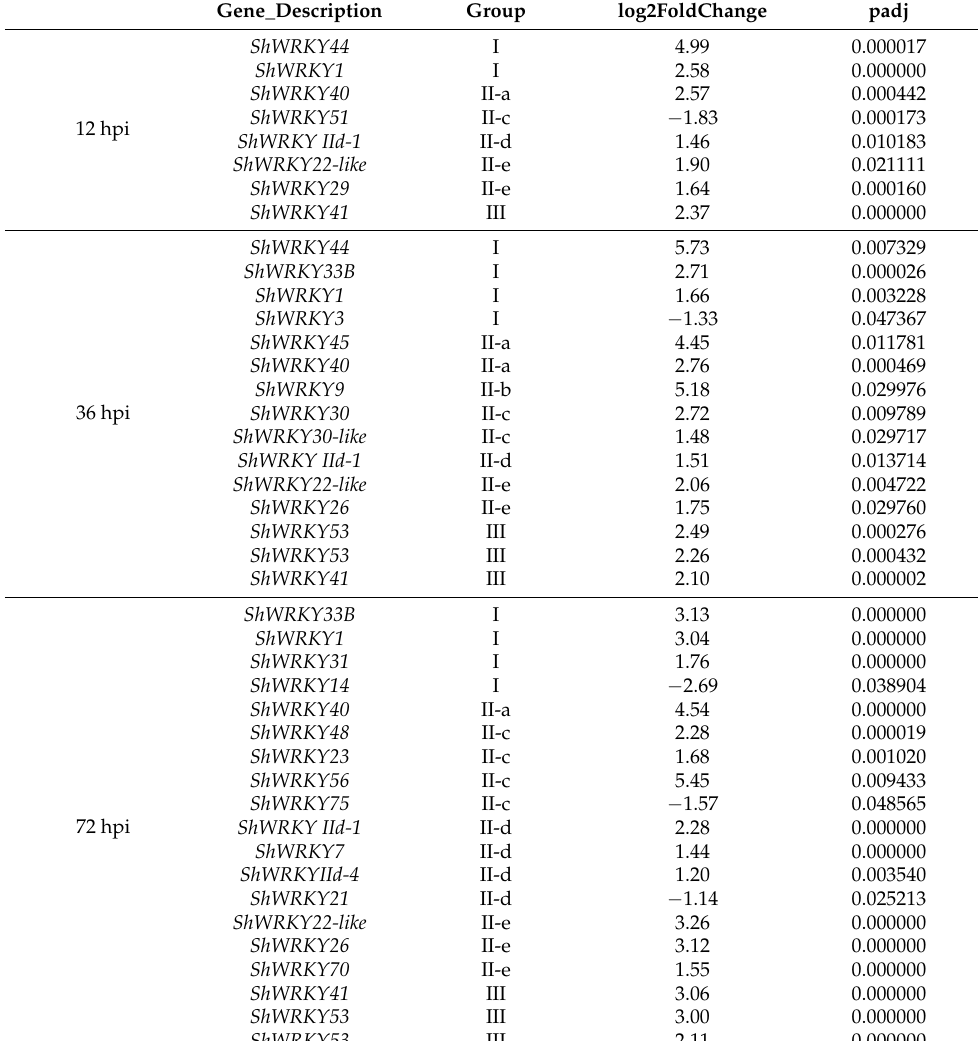
Table 1. Categorization of differentially expressed ShWRKYs under On -lz infection in wild tomato LA1777.